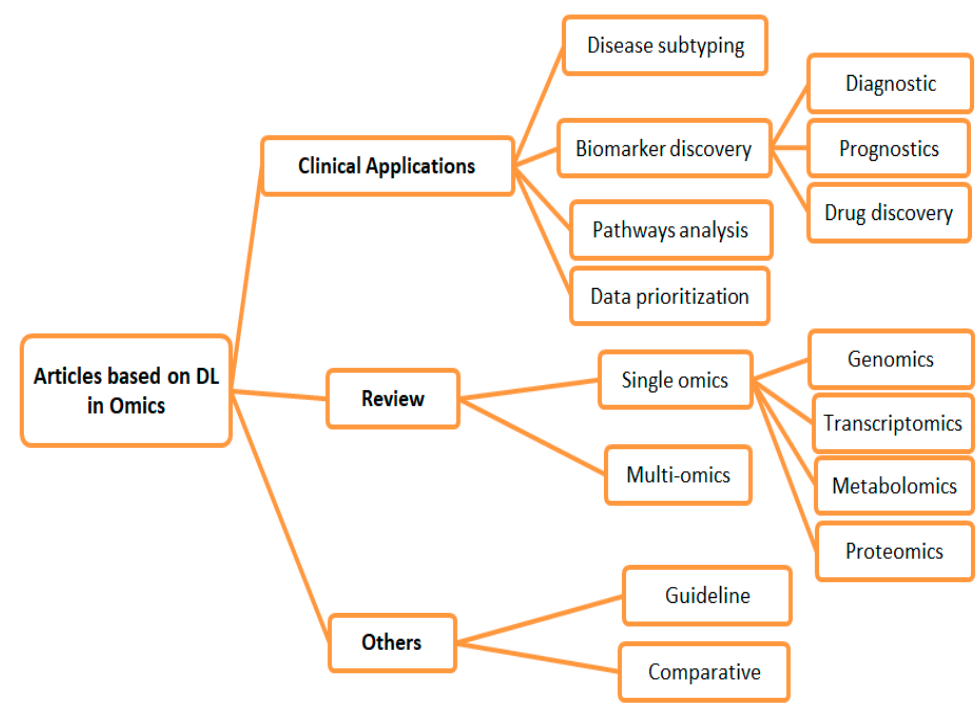
Figure 2. Proposed Figure 2. Proposed taxonomy.